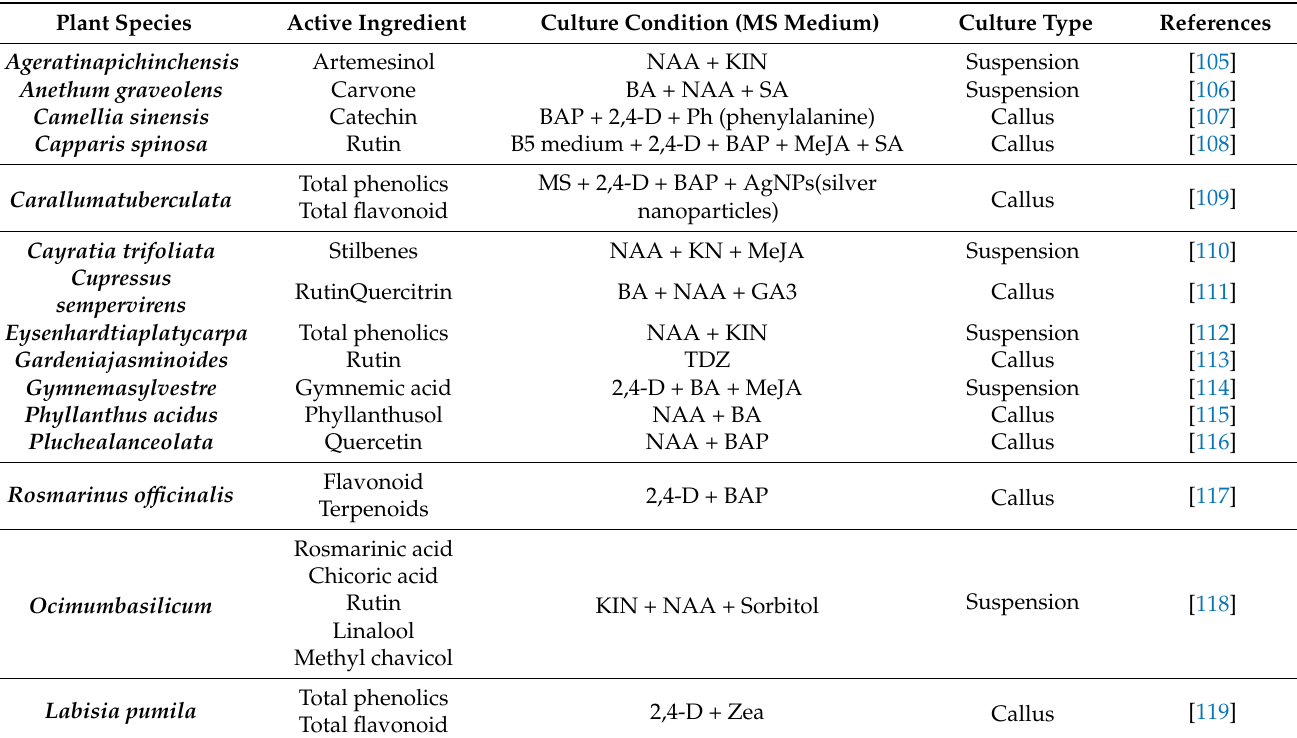
Table 3. List of some applications of cell and suspension culture in the production of sec- ondary